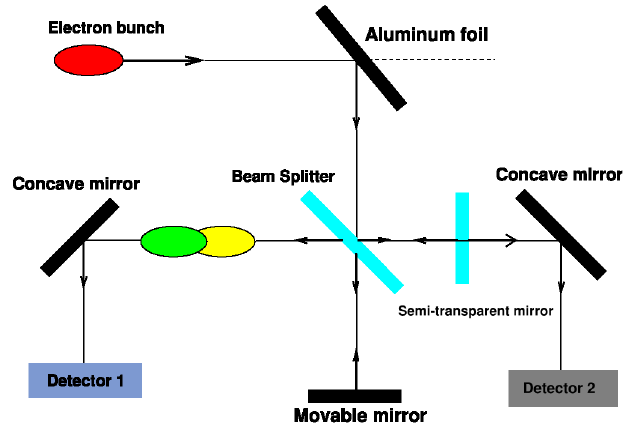
FIG. 1. (Color) Michelson interferometer. Detector 1 is used to record the autocorrelation function. Detector 2 is a reference detector used to normalize the autocorrelation